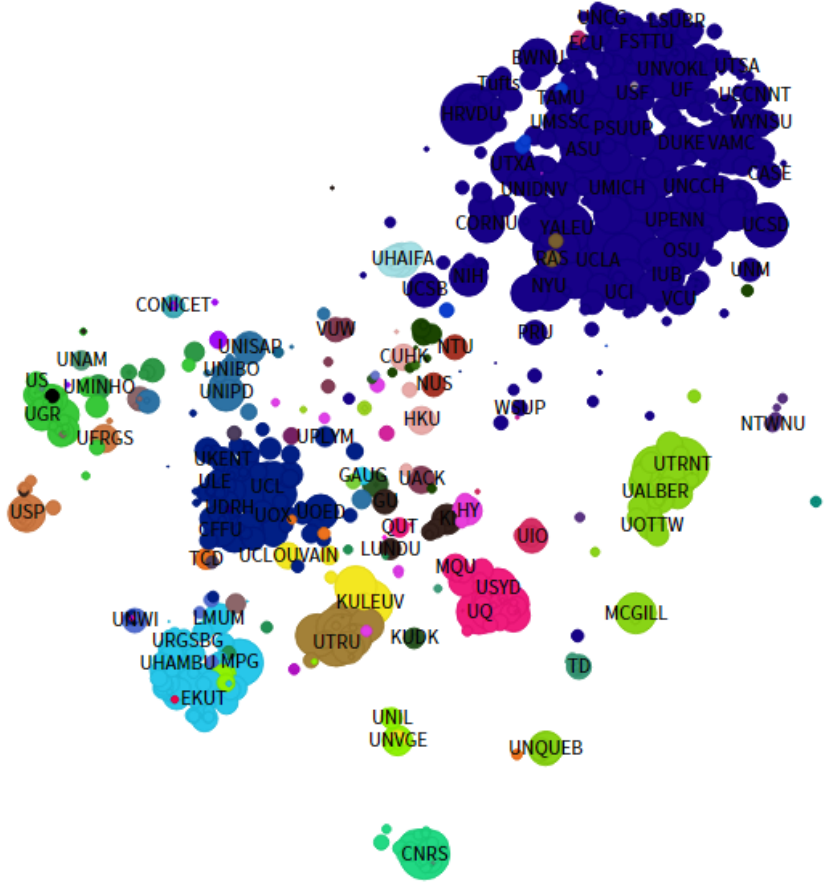
Figure 2. Collaboration network in psychology represented by institutions in 2012, colors correspond to